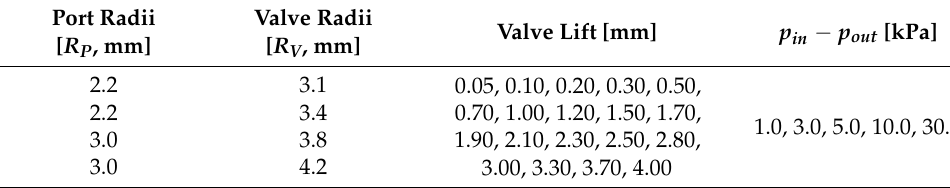
Table 1. Analysis cases (380 cases) ( p out = 100.0